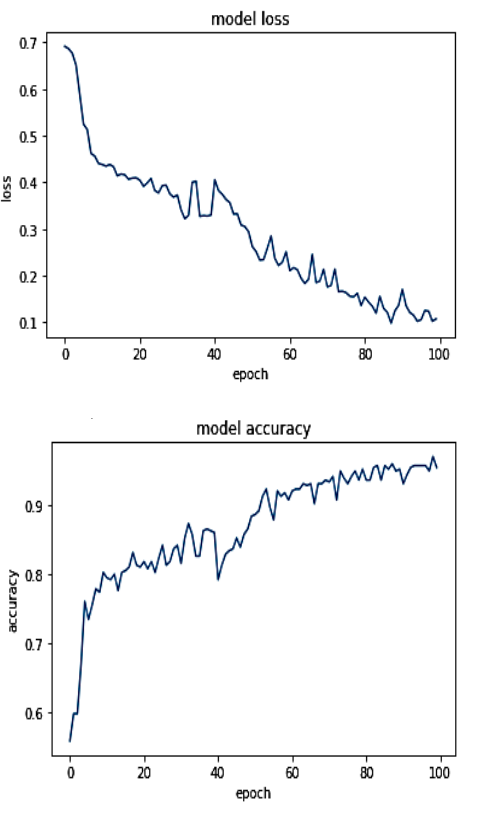
Fig. 6. Loss and accuracy plot of the proposed stacked GRU-LSTM model obtained over epochs. P ERFORMANCE S UMMARIZATION OF A LL RNN-B ASED M